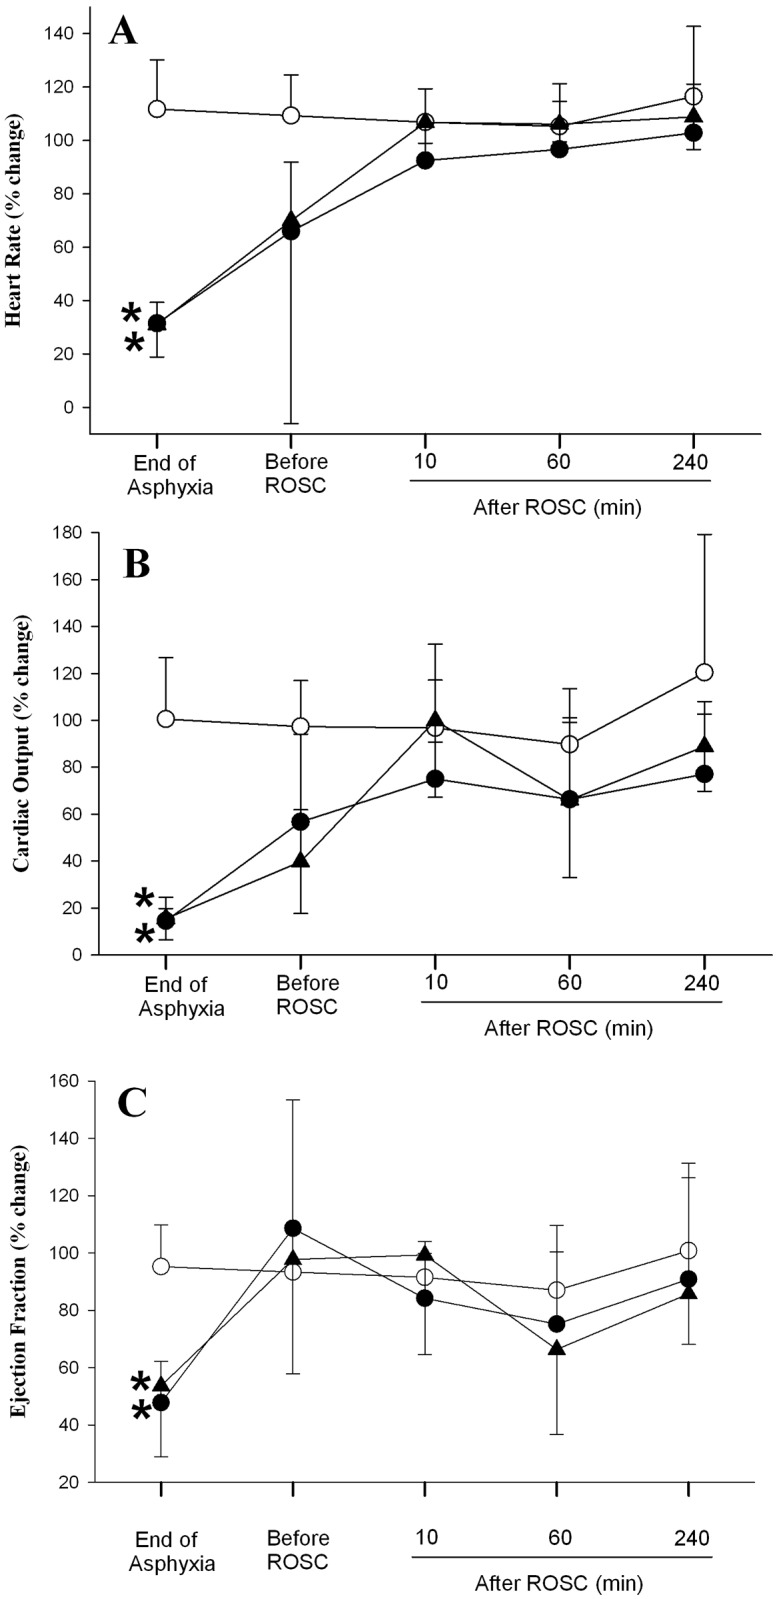
Percent changes from normoxic baseline in (A) heart rate, (B) cardiac output, and (C) ejection fraction in sham (◯), SI+CC 90 (●), and SI+CC 120 (▴) groups during and after resuscitation.Each point represents mean±SD. *Significantly different from sham-operated group, p<0.05 (Tukey).